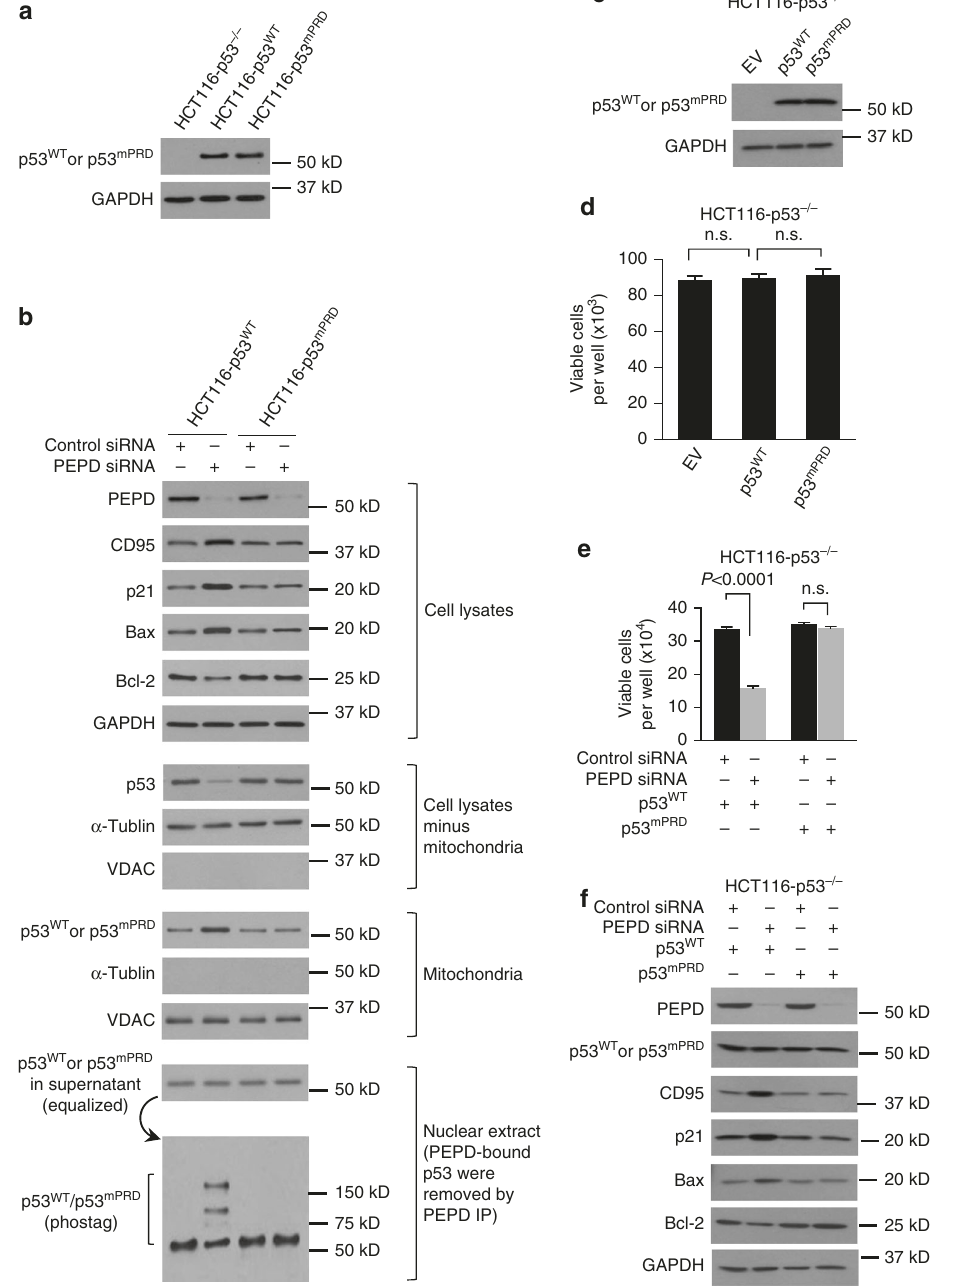
Nuclear extract (PEPD-bound p53 were removed by